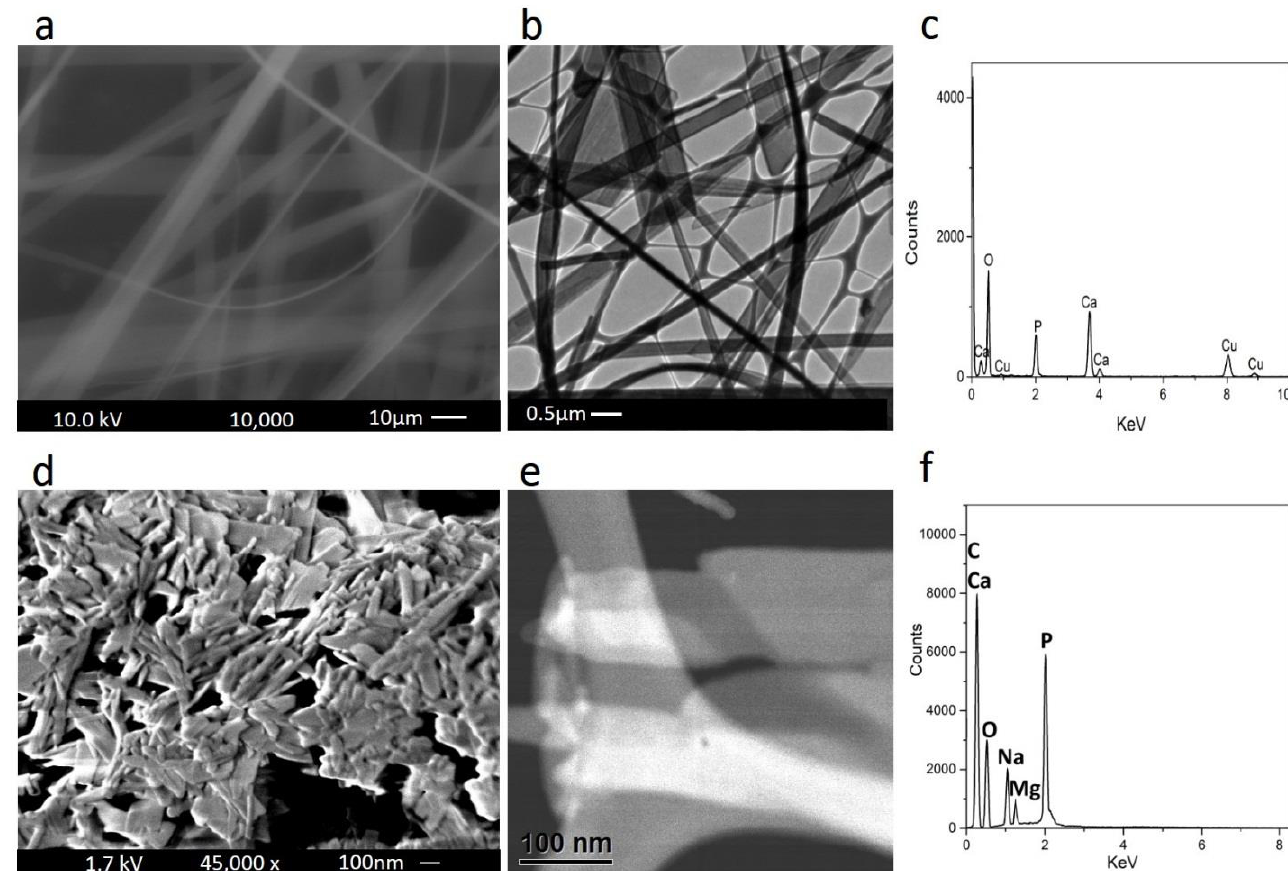
Figure 1. FESEM image, TEM image, and EDS spectra of ( a – c ) HA nanofibers and ( d – f ) MgP nanosheets.